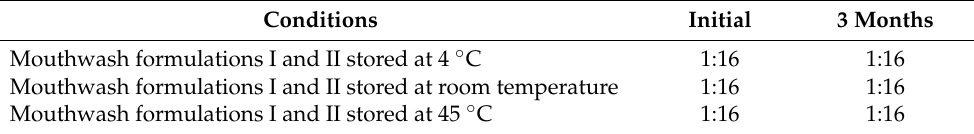
Table 3. The stability of mouthwash formulation I and II on S. mutans biofilm formation based on MIC